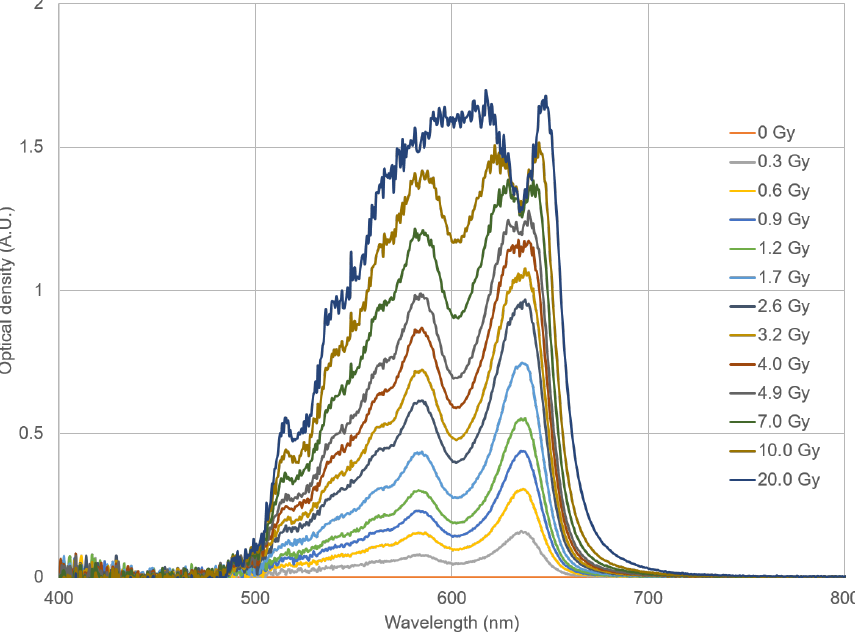
Figure 7. Spectral response (in optical density) of EBT3 Gafchromic™ films exposed to doses in the range 0–20